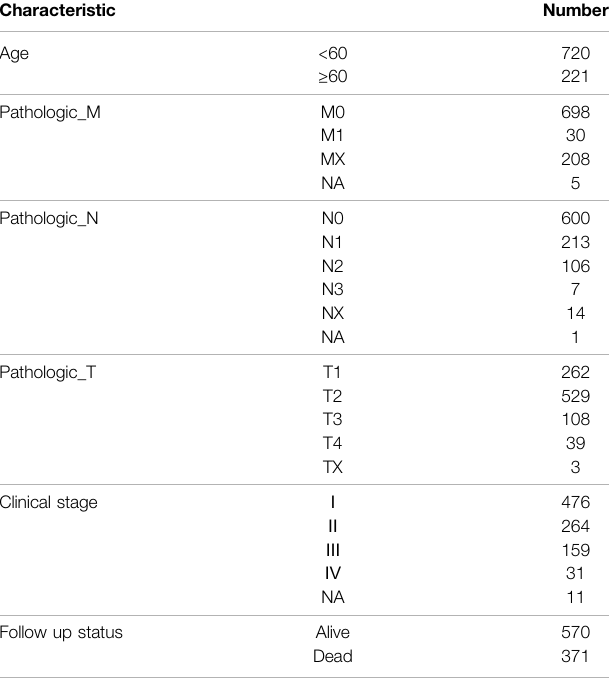
TABLE 1 | Clinic pathological data of patients with NSCLC in this study.